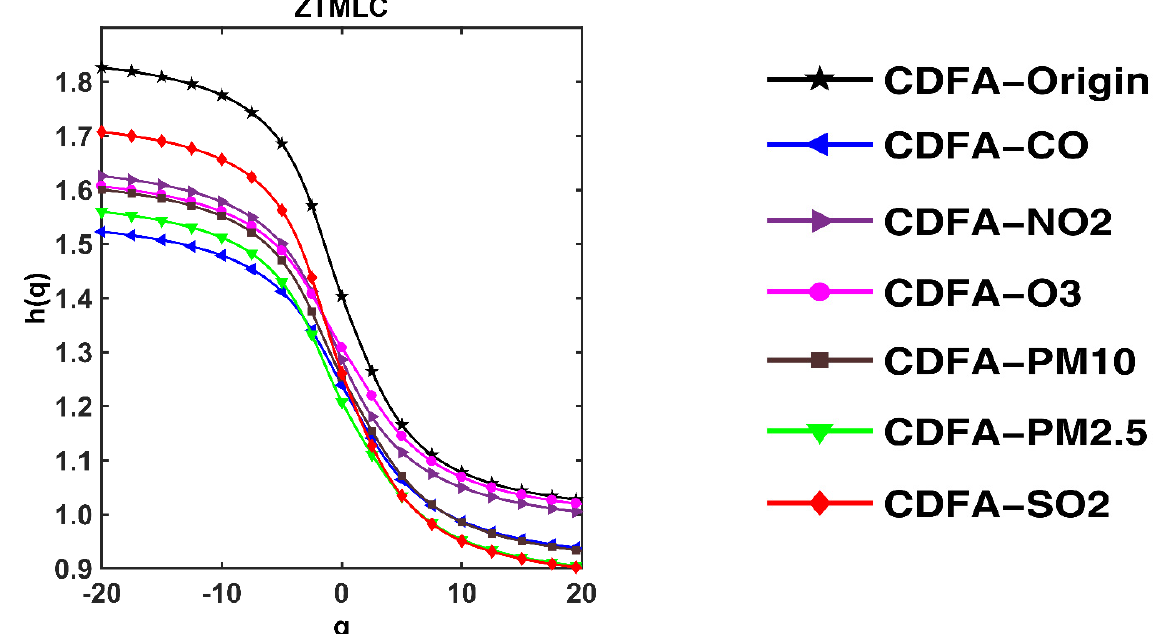
Figure 5. The behaviors of q ~ h ( q ) of 6 pollutants in nine monitoring stations in Zhengzhou after CDFA analysis, only the mentioned time series is shuffled and the other time series are kept unchanged.